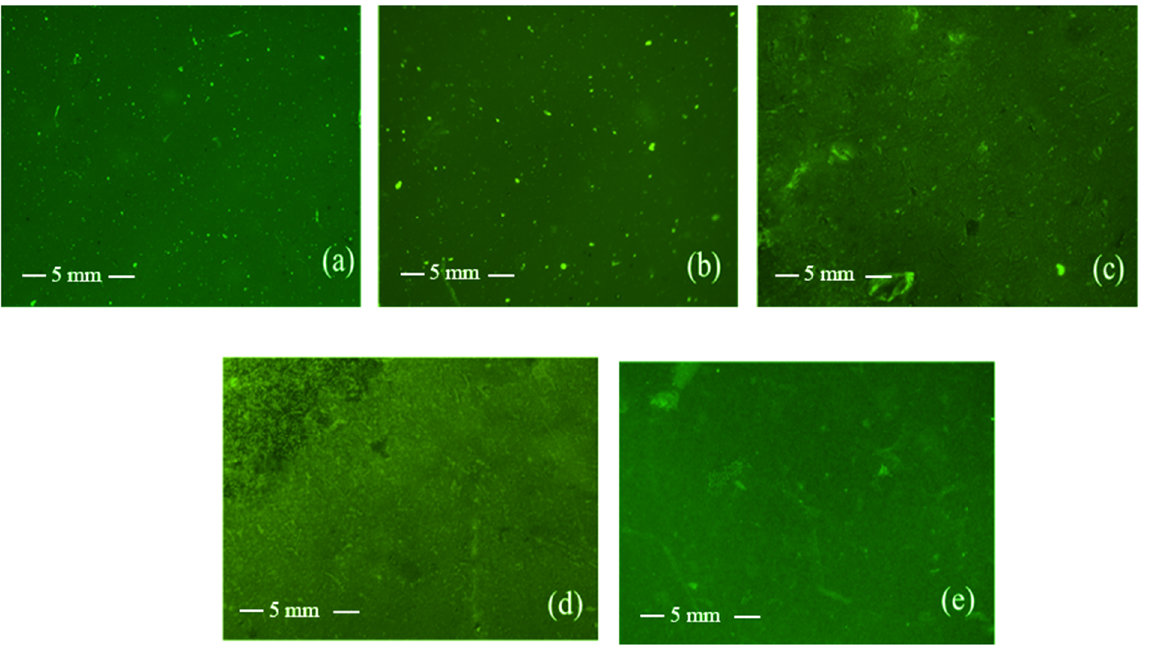
Figure 9. Fluorescent microscopy images of film surfaces of CHI ( a ) and their blends ( b – e ). Content of P3HPEI in the blends: 20 ( b ), 40 ( c ), 60 ( d ), and 80% ( e ) at 20 ×